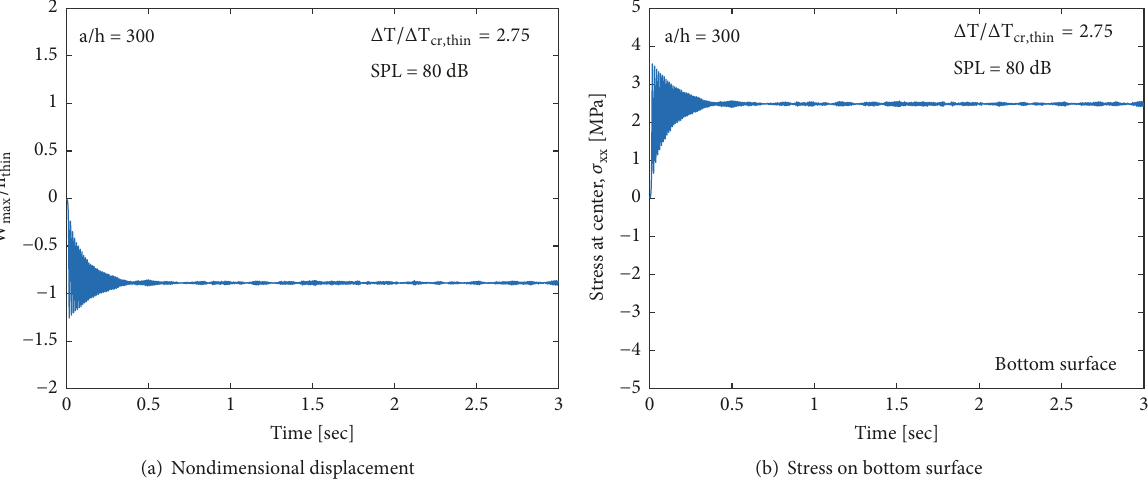
Figure 6: Random vibrations about buckled position (a/h = 300).